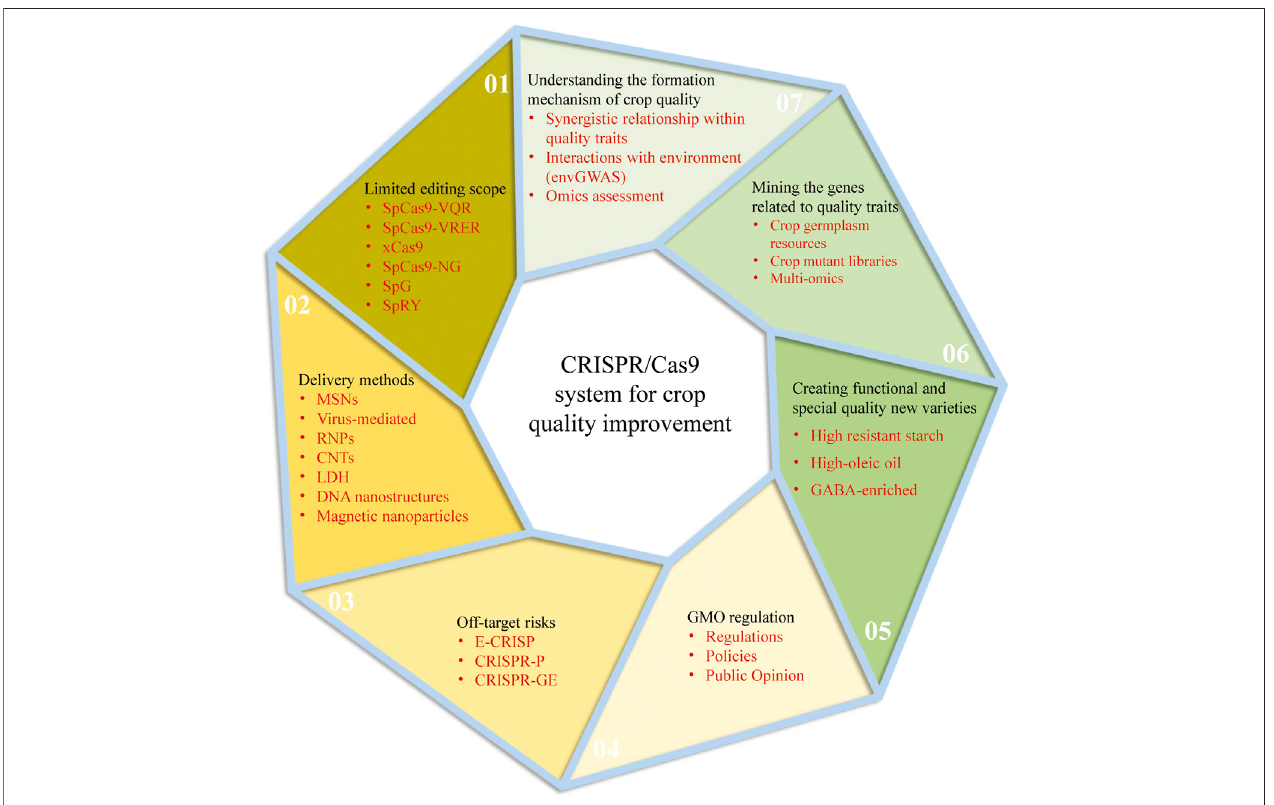
FIGURE 2 | The current challenges and perspectives of the CRISPR/Cas9 system and the future development trend of crop quality improvement.